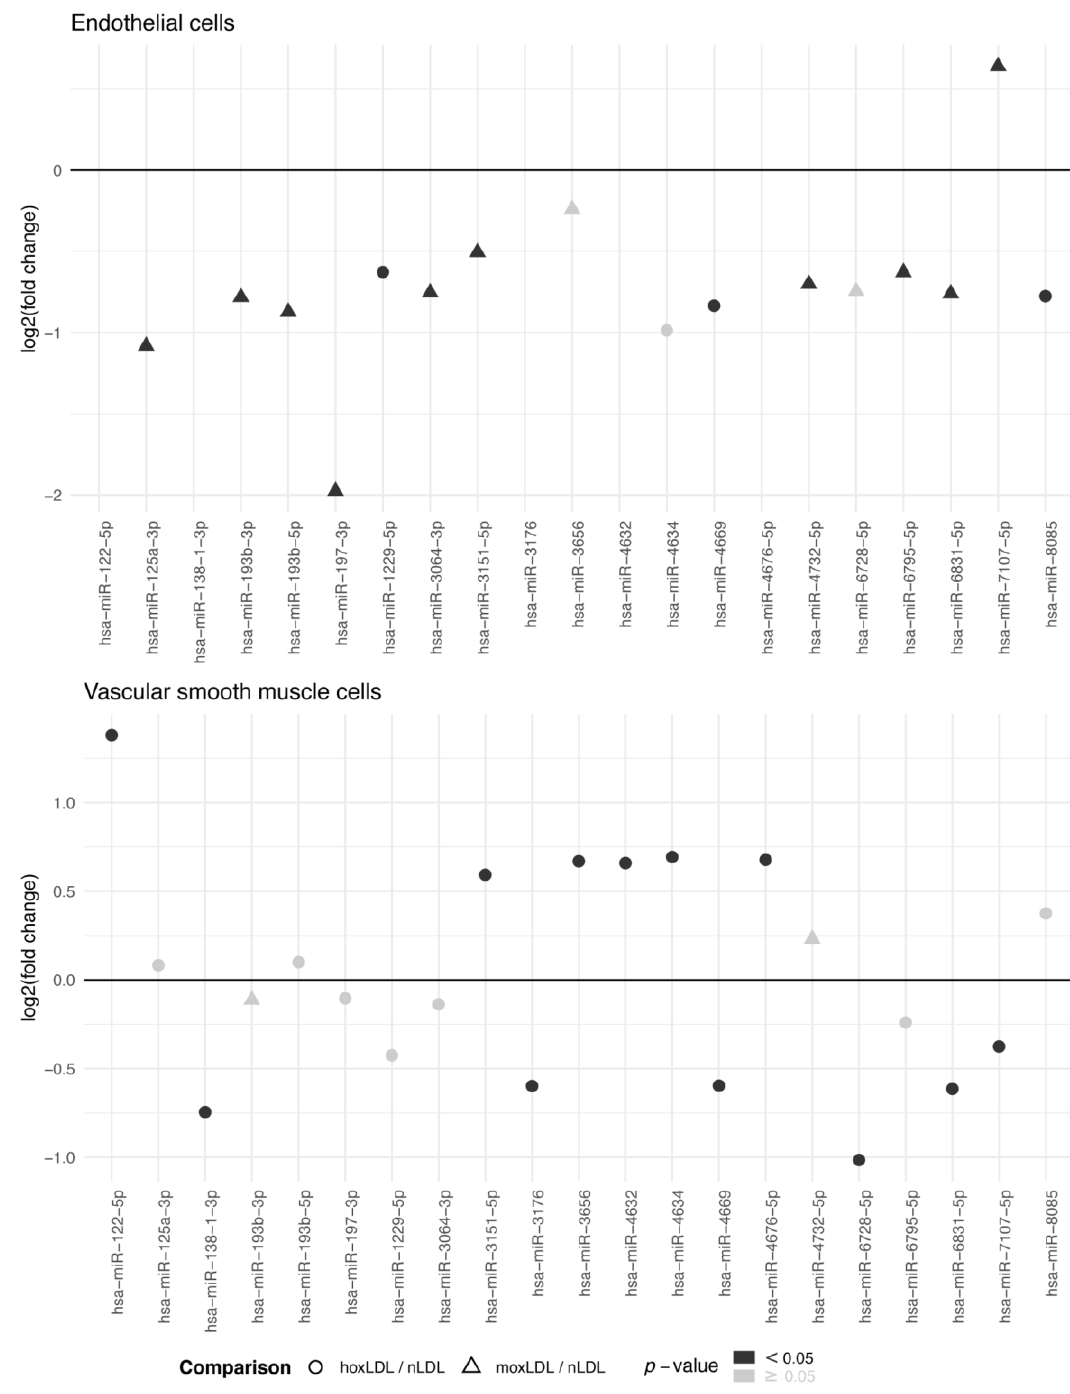
Figure 1. Differentially expressed miRNAs in human endothelial and vascular smooth muscle cells after treatment with oxidized low-density lipoproteins. miRNA expression was measured with microarrays in RNA extracted from cells (obtained from three individuals without cardiovascular disease) treated with native, moderately oxidized or highly oxidized low-density lipoproteins (nLDL, moxLDL, or hoxLDL, respectively). Differential expression of miRNAs was examined with moderated t-tests. Only the differentially expressed miRNAs in at least one cell type which expression followed a linear or quadratic trend between nLDL, moxLDL, and hoxLDL conditions are shown. p -values were not adjusted for multiple comparisons. Expression values are presented in Table S5. Log2(fold change): binary logarithm of the fold change.